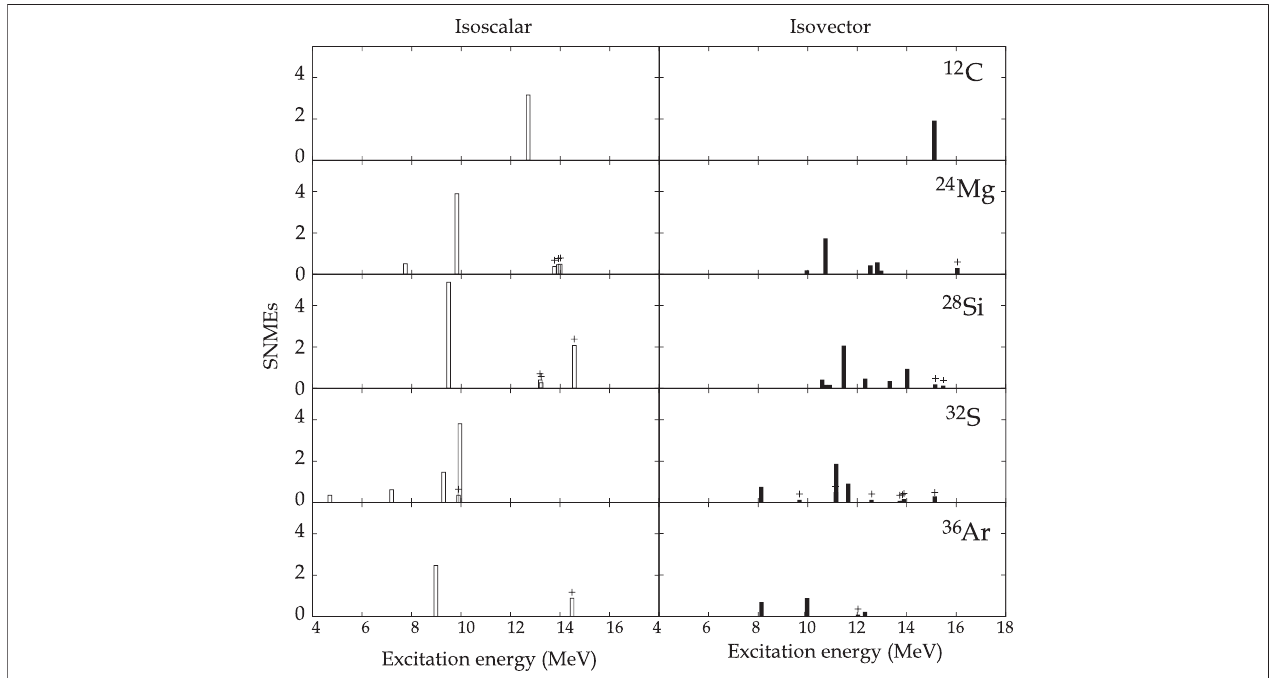
FIGURE 7 | Observed distributions of spin- M 1 SNMEs. The bars labeled + indicate states with a less con fi dent spin assignment. The fi gures were taken from Matsubara et al. (2015) with 12 C data added.